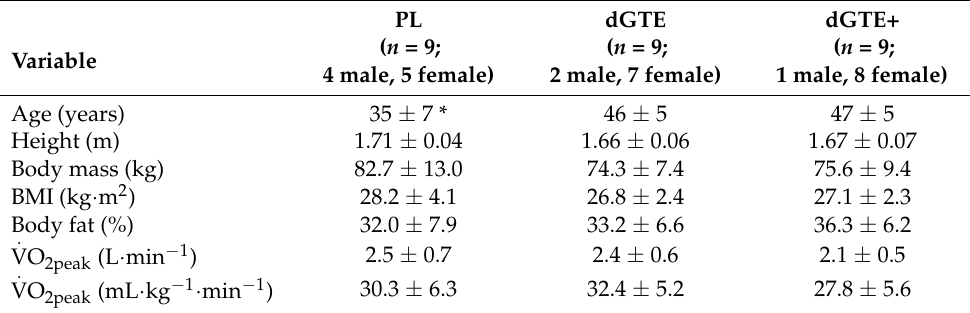
Table 1. Baseline characteristics for intervention